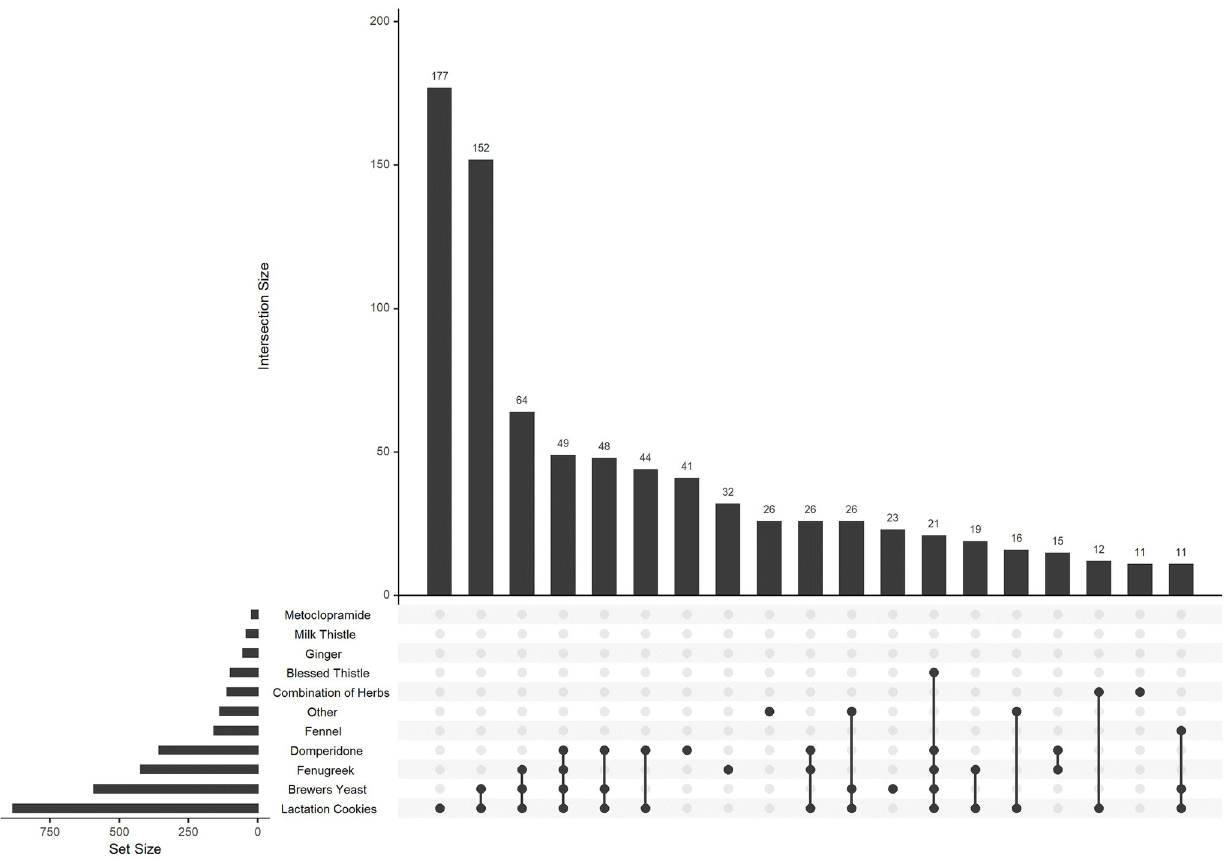
Fig 1. UpSet plot showing the use of different galactagogues and combinations thereof in breastfeeding women (n = 1120).